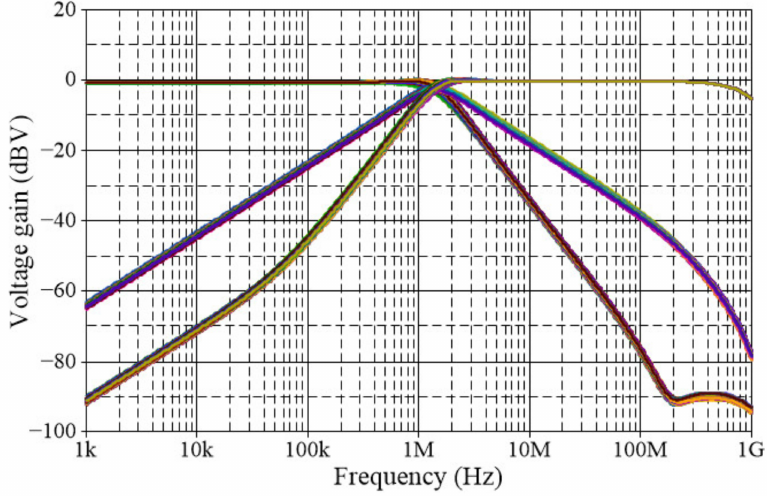
Figure 14. Monte Carlo statistical analysis results for LP, BP, and HP responses in VM.